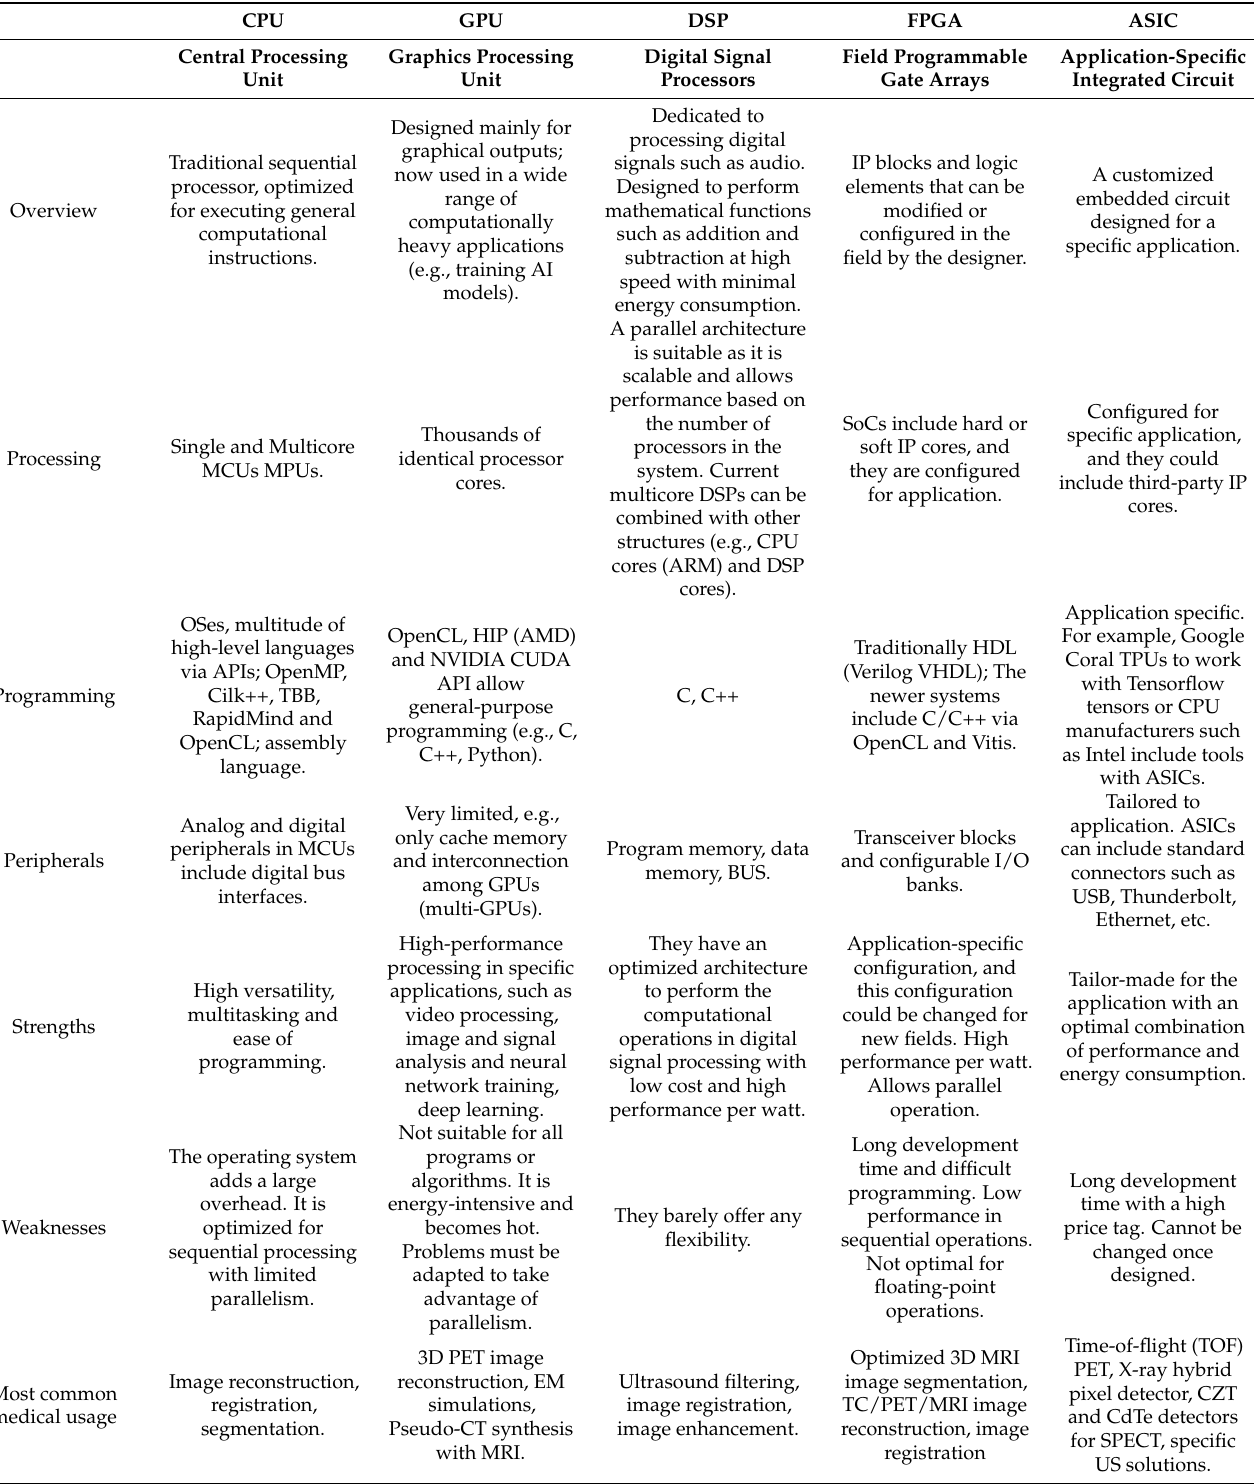
Table 1. Summary comparison chart for CPU, GPU, DSP, FPGA and ASIC hardware